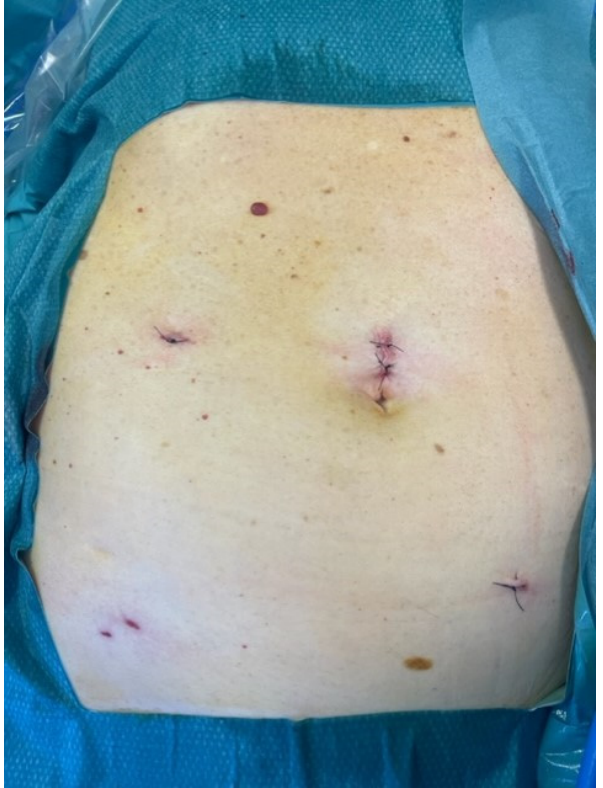
Figure 3. Early cosmetic results after the operation.